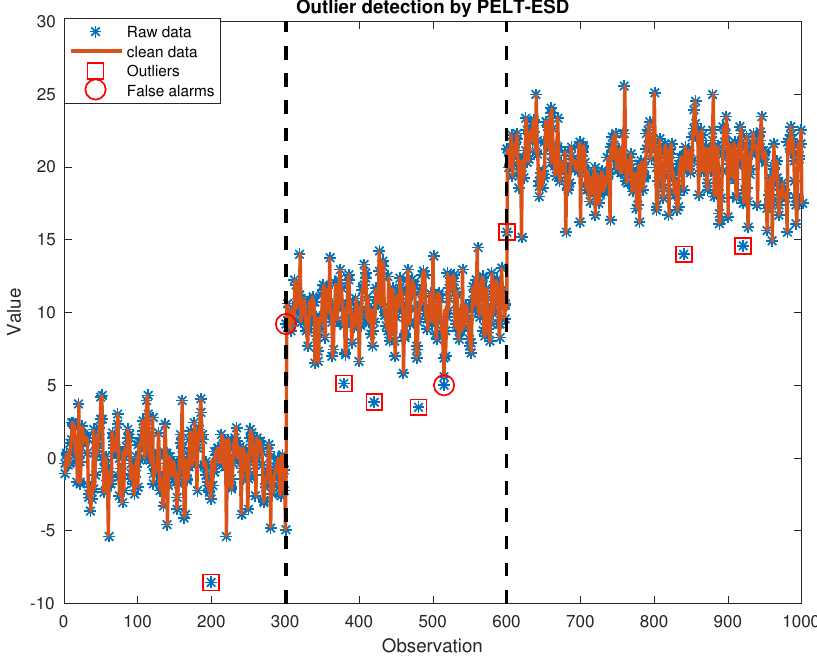
Figure 4. Outlier detection by pruned exact linear time—general extreme studentized deviate